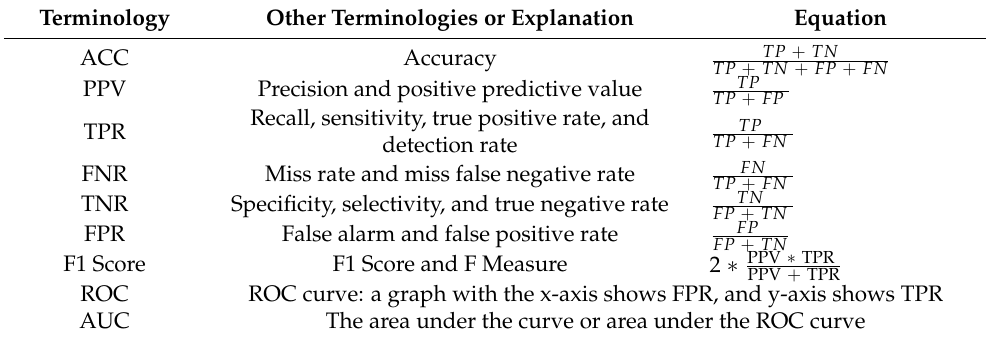
ROC curve: a graph with the x-axis shows FPR, and y-axis shows TPR AUC The area under the curve or area under the ROC